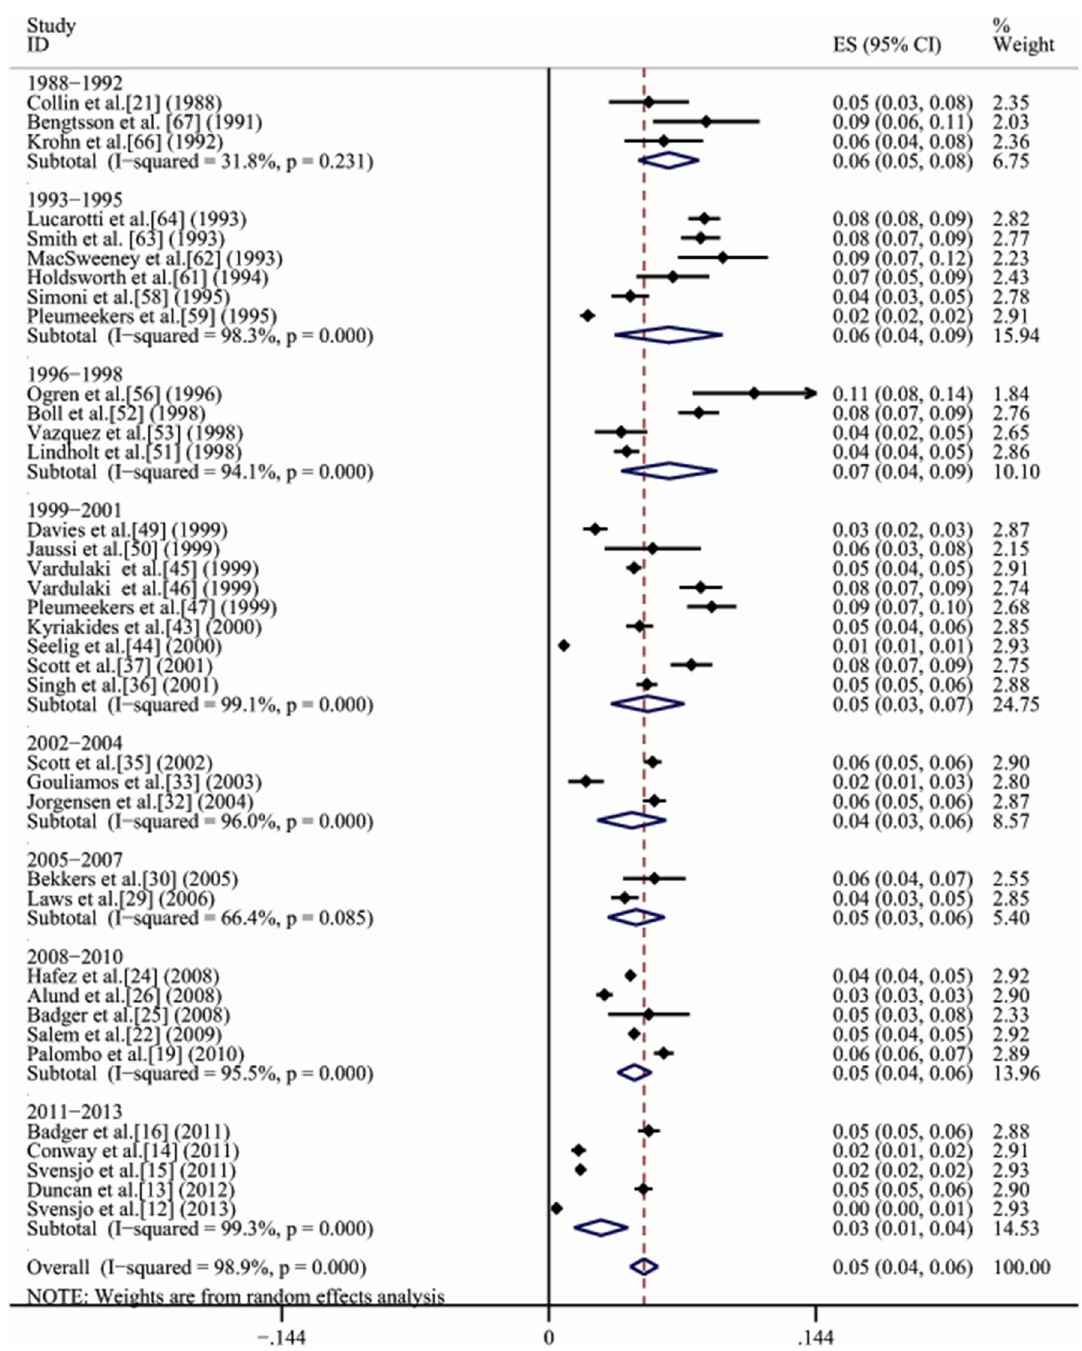
Figure 4. A forest plot of prevalence of AAA in Europe from 1988 to 2013.